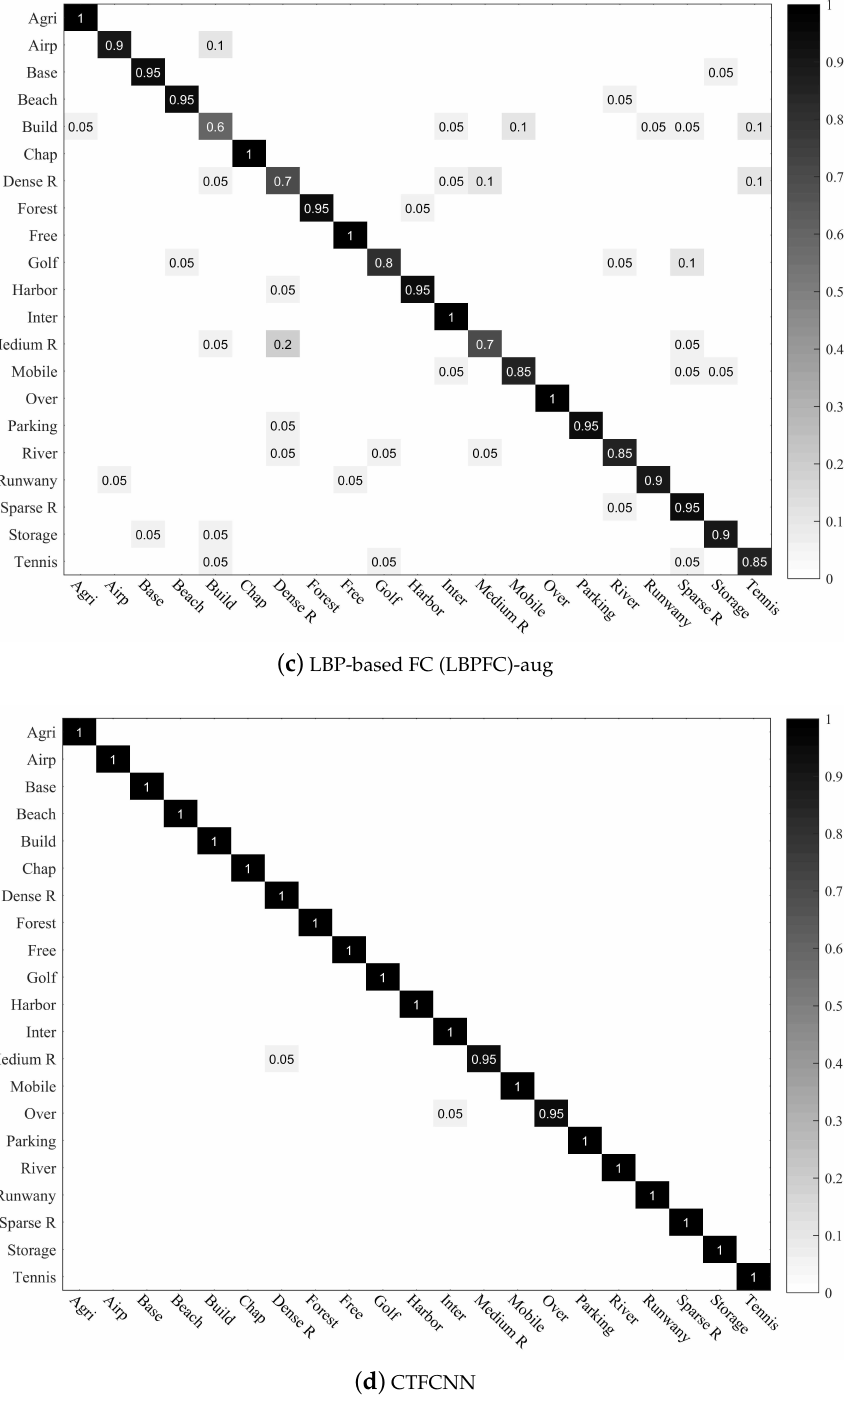
Figure 10. Confusion matrices of CTFCNN for the UC-Merced dataset. In confusion matrices, each row denotes the instances in actual category, and each column of the matrix denotes the instances in a predicted category. Blank positions indicate that the value is 0, and the diagonal data indicates the accuracy of each